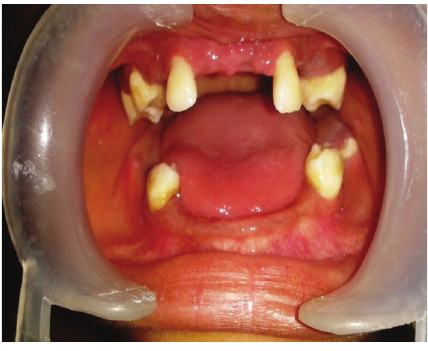
Figure 14: Showing mixed dentition and missing teeth in relation to upper and lower anterior ends.